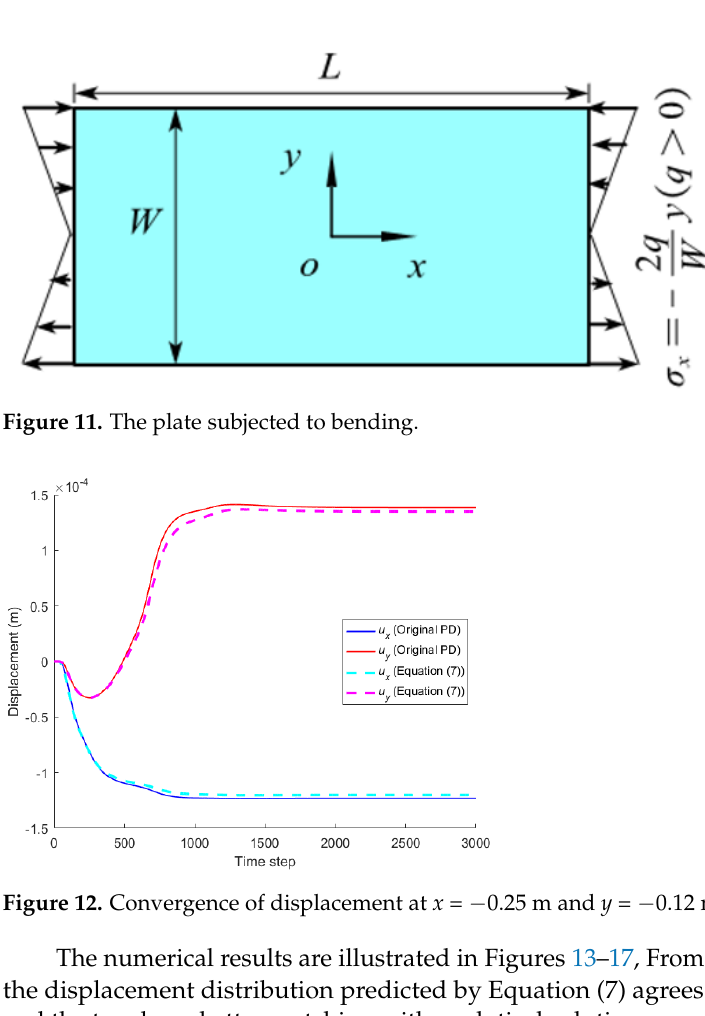
Figure 12. Convergence of displacement at x = − 0.25 m and y = − 0.12 m with time step.